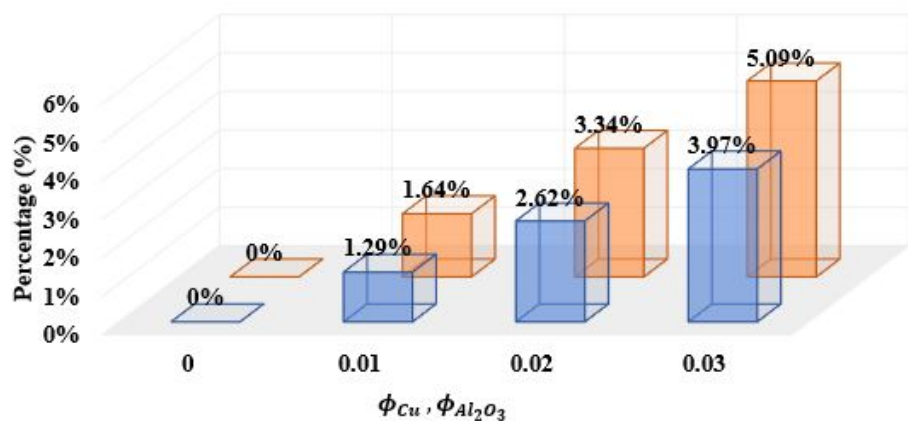
Figure 7. Percentage versus φ Cu , φ Al